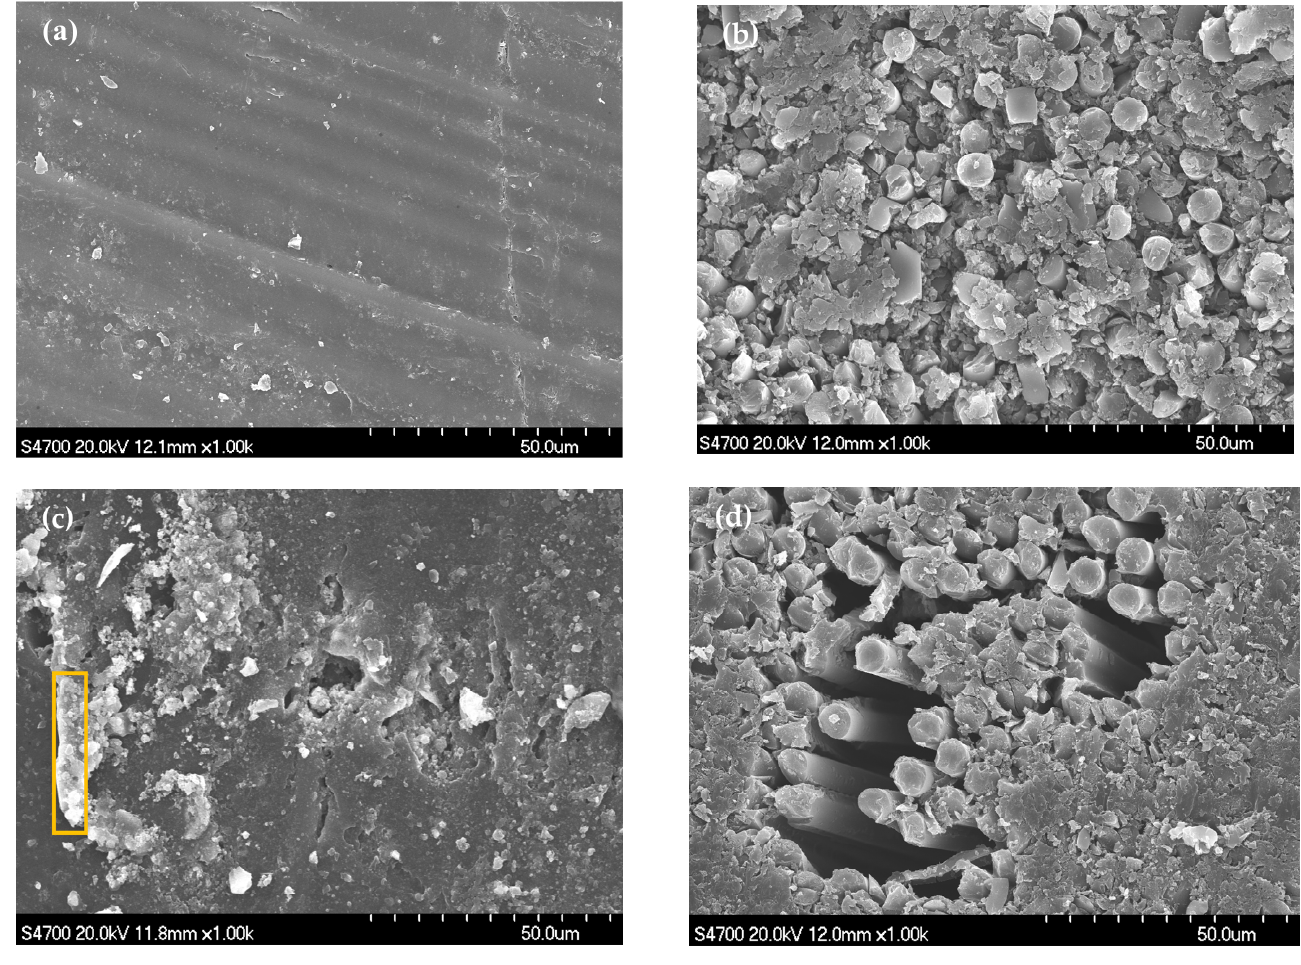
Figure 5. SEM images of the 700/VE specimen. ( a , b ) before immersion; ( c , d ) 205 d of immersion.